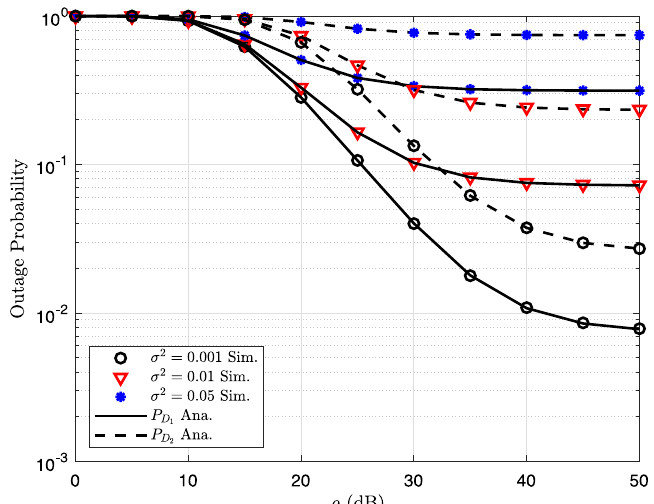
Fig. 4 Outage performance vs ρ (dB) varying σ 2 with the satellite link under